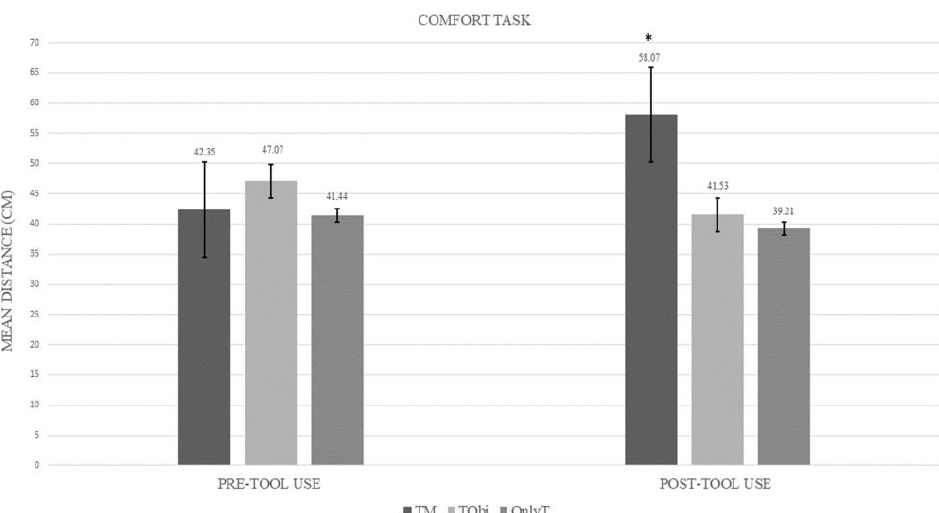
Figure 3. The graph shows the mean comfort distance (in cm) as a function of the three groups (OnlyT: Only Tool; TM: Tool plus Mannequin; TObj: Tool plus Object) and the Pre-tool-use and the Post-tool-use conditions. The asterisk indicates the experimental condition that differs significantly from the others. More specifically, the Post-tool-use distance in the TM group was significantly different from the Post-tool-use distance in the other two groups and from the Pre-tool-use distance in the OnlyT and TM groups. Error bars represent the standard error.